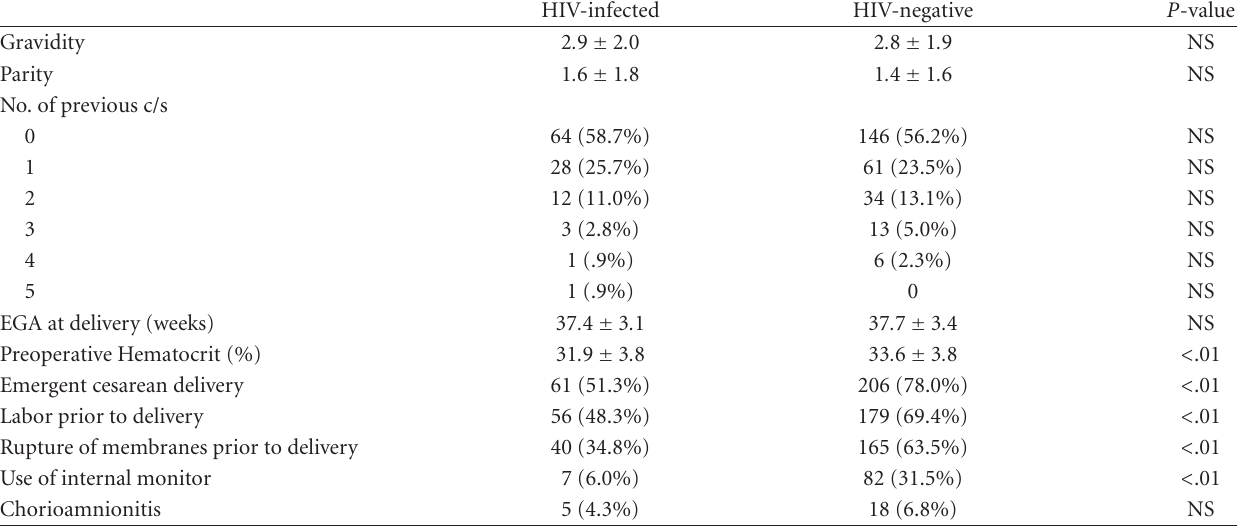
Table 2: Obstetrical characteristics.